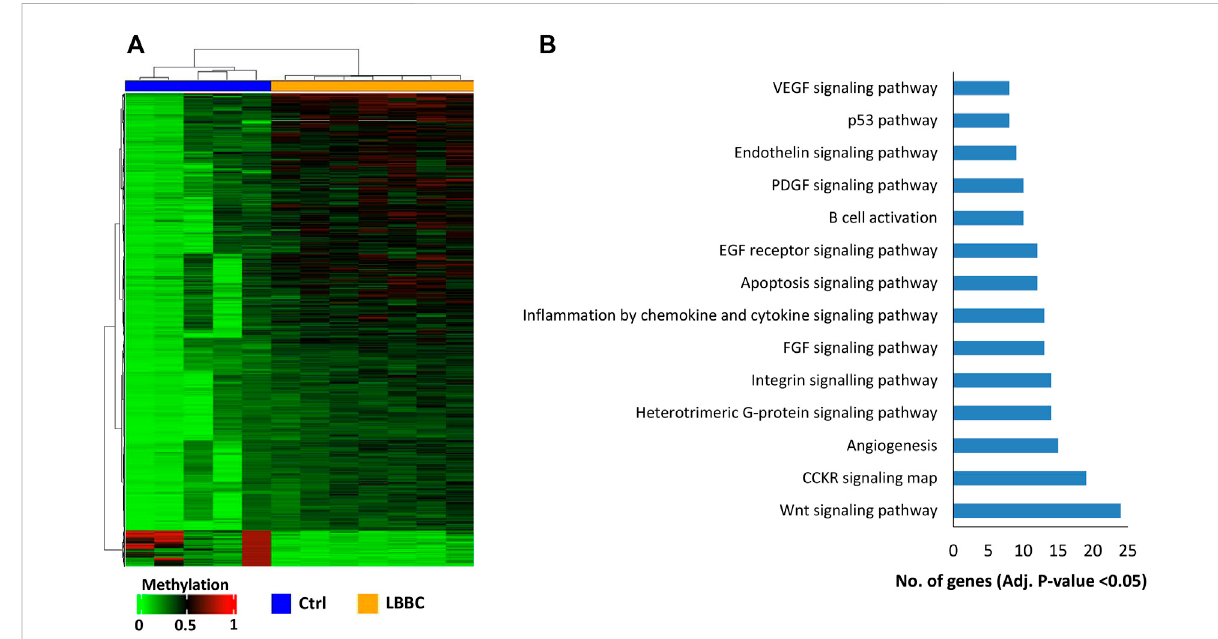
FIGURE 2 Episignature of cell-free DNA in metastatic patients with luminal B breast cancer. (A) Unsupervised hierarchical clustering heatmap of the episignature (1,467 DMCpGs) obtained in cfDNA that differentiates LBBC patients ( n = 7) from nontumor controls ( n = 5). (B) Gene Ontology enrichment analysis by the PANTHER database, showing the most representative pathways associated with the episignature of cfDNA in luminal B breast cancer patients. Ctrls, controls; LBBC, luminal B breast cancer; DMCpGs, differentially methylated CpGs; cfDNA, cell-free